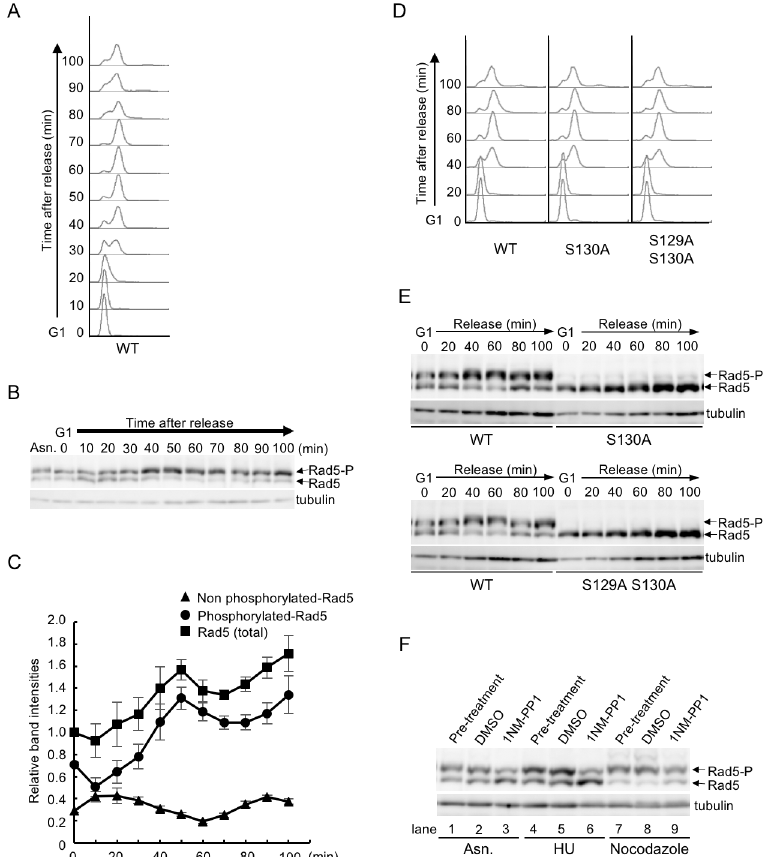
Fig 4. Elevated phosphorylation levels of Rad5 at S130 during the S to G2/M phases. (A, B) RAD5-Myc cells grown to early log phase at 30˚C were arrested in G1 with α -factor for 2 h. Cells were then released into fresh YPDA medium. Samples from synchronized cell cultures were taken at the indicated time points after release from G1 block. Cell-cycle progression was determined by flow cytometry (A) and Rad5 protein was analyzed by Phos-tag western blotting (B). Tubulin served as a loading control. Asn denotes asynchronously growing cells. (C) Total amount of Rad5 is shown as relative band intensities together with the ratio of the relative amount of the two bands. Values are expressed relative to 1.00 for total amount of Rad5 at time zero. Error bars are derived from standard errors of the three independent experiments. (D, E) RAD5-Myc , rad5-S130A and rad5-S129A S130A cells were grown to log phase, arrested at G1 by α - factor, and then released into fresh YPDA medium. Cell cycle progression was analyzed by flow cytometry (D) and Rad5 protein levels were analyzed by Phos-tag western blotting (E). (F) cdc28-as1RAD5-Myc cells were grown to log phase or arrested at S phase with 200 mM HU or at G2 phase with 20 μ g/ml nocodazole. After 2 h, cultures (pre- treatment) were divided equally and treated with DMSO (mock) or 5 μ M 1NM-PP1 for 1 h. Rad5 protein was analyzed by Phos-tag western